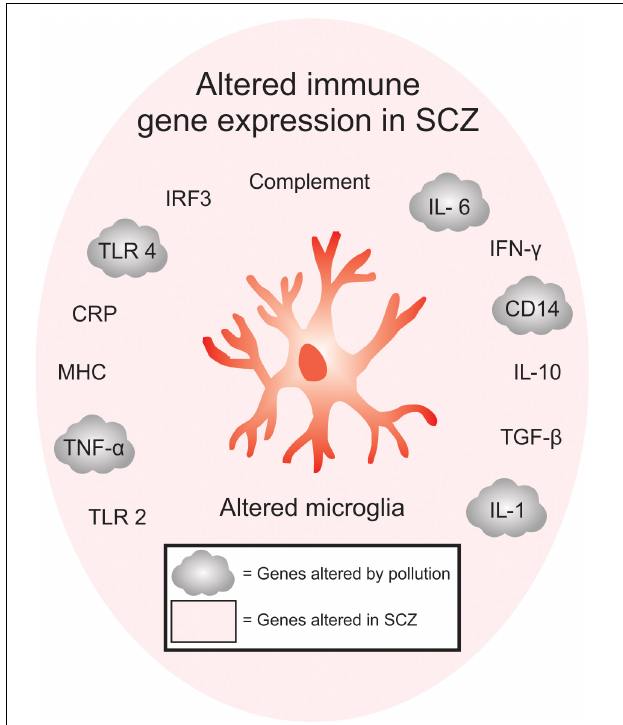
FIGURE 1 | Overlap between immune-signaling genes that are associated with pollution and SCZ. Of the immune genes that are associated with SCZ, many are also found to be altered either in humans or animals exposed to pollutants, offering a genetic point of convergence between changes in pollution-mediated inflammatory signaling and SCZ. Inflammatory gene expression, including TLR2, TNF- α , MHC, CRP, TLR4, IRF3, complement pathway, IL-6, IFN-y, CD14, IL-10, TGF- β are altered in SCZ, while TNF- α , TLR4, IL-6, CD14 and IL-1 are altered in SCZ and after exposure to air pollution. These genes are specifically enriched in